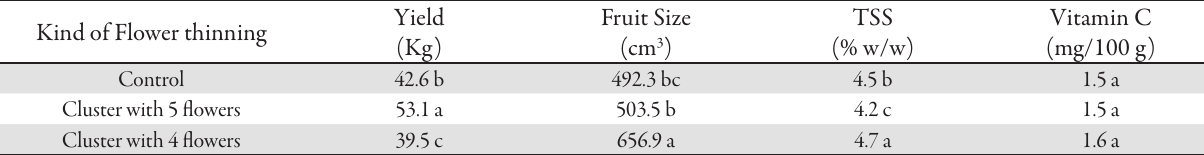
Tab. 3. Effect of flower thinning on quality and quantity of semi-determinate tomato in greenhouse Kind of Flower